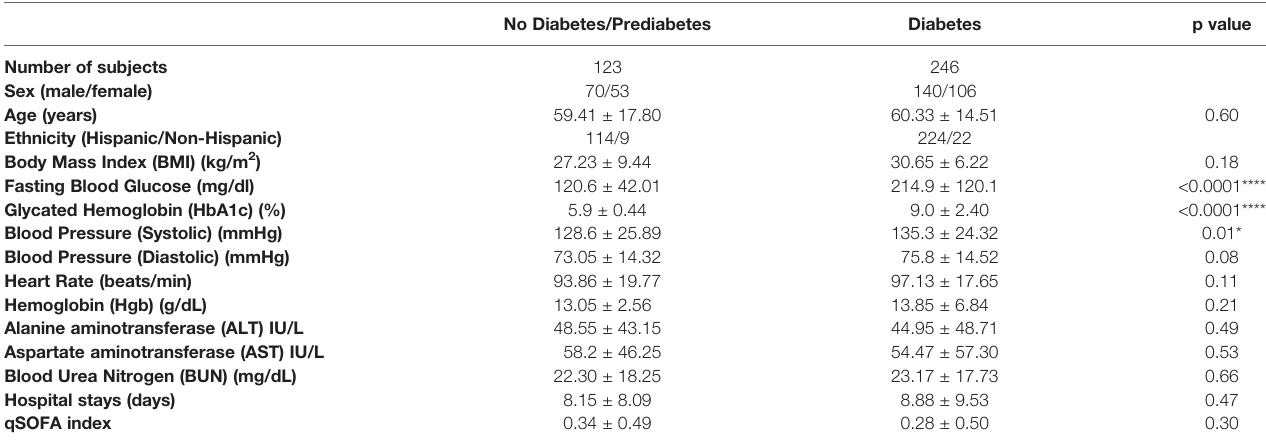
TABLE 1 | Study subject characteristics.